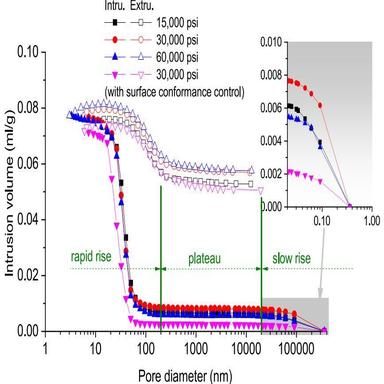
Accumulative TSDs of the porous cement paste samples from both the intrusion and extrusion branches in different maximum applied pressures and surface conformance conditions.